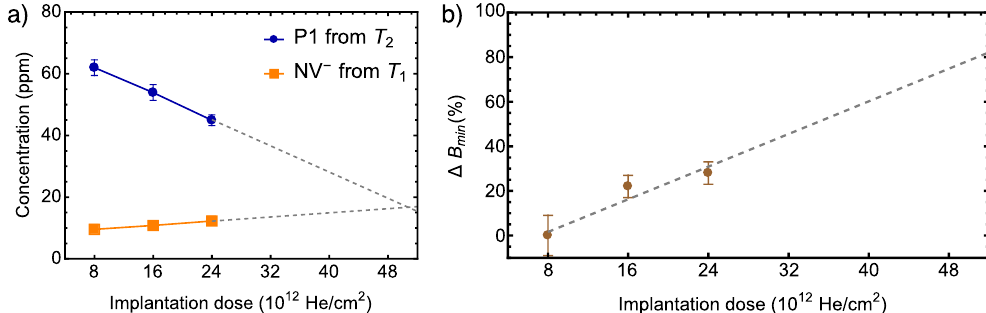
Figure 5. Projected values: ( a ) Linear extrapolations of P1 and NV − concentrations to higher implantation doses. The optimal dose is expected at 0.5 × 10 14 He + /cm 2 where the P1 concentration is equal to the NV − concentration. ( b ) The linear extrapolation to higher implantation doses of relative improvement of sensitivity (minimum detectable magnetic field B min , see Equation